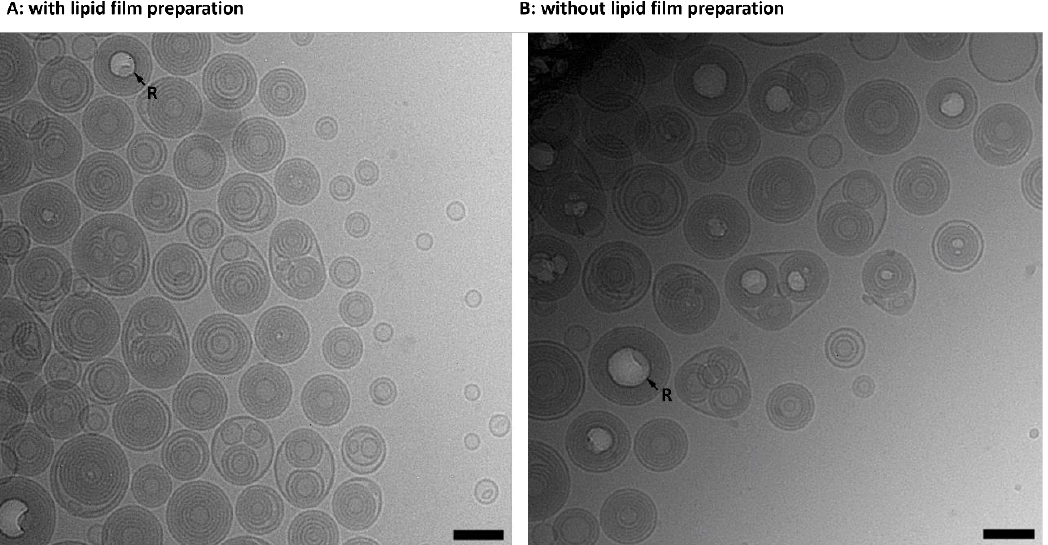
Figure 5. HEPC/Chol 55/45 (mol%) liposomes prepared with ( left ) and without ( right ) lipid film preparation in organic solvents. Preparation at 60% lipid concentration by DC at 2350 rpm, at 20 °C, and for 30 min. Arrows (R) indicate radiation damage due to the dense material nature of the multilamellar liposomes. Scale bar: 100 nm.